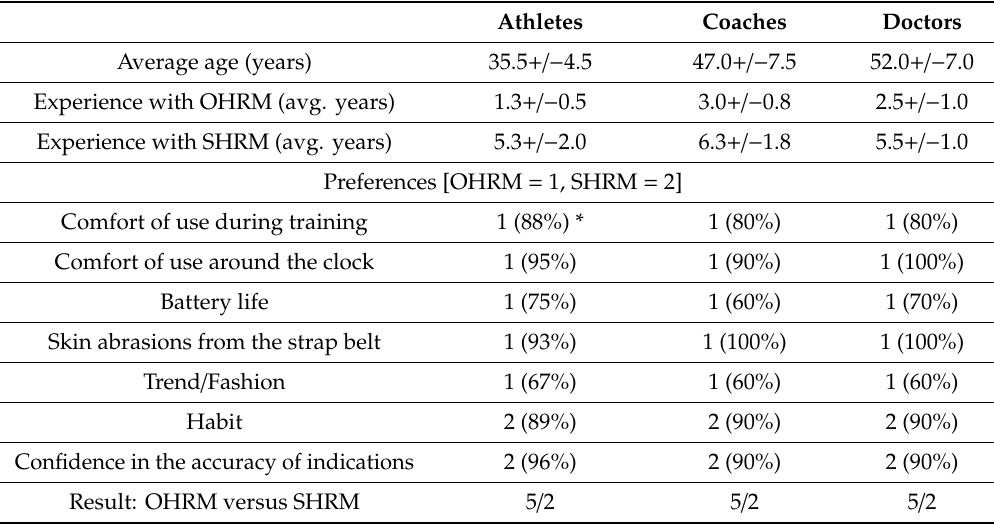
Table 1. Reasons for preferential use of wrist-worn optical heart rate monitors versus chest strap HRMs by athletes, coaches, and doctors, assuming that the HRMs have the same functions and the same resistance to